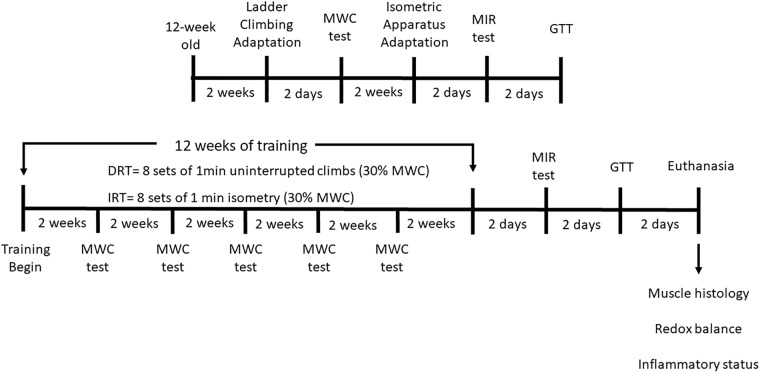
Experimental design. DRT, dynamic resistance training; IRT, isometric resistance training; MWC, maximal weight carried; MIR, maximal isometric resistance; GTT, glucose tolerance test. Male Wistar rats were selected at 12 weeks old. All rats were submitted to familiarization with dynamic strength exercise for 2 weeks. Two-days after, the animals were submitted to the maximal weight carried (MWC) test. Afterward, the animals were adapted to the isometric exercise for 2 weeks. Subsequently, the MIR and GTT tests were carried out, both tests were applied with 2 days of difference between them. Then, the rats of the DRT and IRT groups trained for 12 weeks, each one with their respective muscular action, dynamic and isometric, respectively. Muscle strength (MWC) was measured every 2 weeks throughout the training protocol, in order to evaluate the muscular strength behavior and to adjust the training load. After the end of the training, the MIR and GTT tests were applied with 2 days of difference between them. Euthanasia was performed after 2 days, the quadriceps and tibialis anterior muscles were collected for evaluation of the transverse section. The parameters of the redox and inflammatory state were measured in the tibilialis anterior muscle.